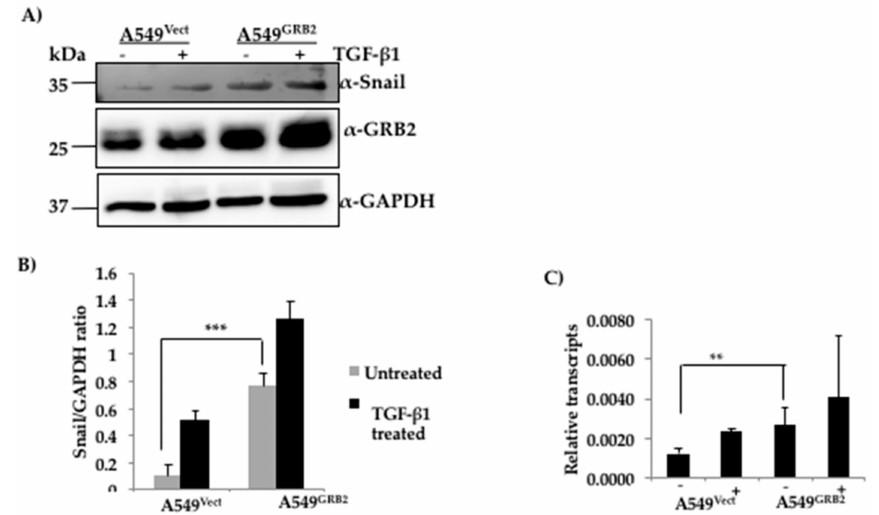
Figure 5. Expression of SNAIL is increased in GRB2 overexpressing A549 cells. ( A ) Protein extracts from A549 Vect and A549 GRB2 cells, before and after TGF- β 1 treatment, were subjected to Western blot using antibodies against Snail and GRB2. GAPDH was used as the loading control; ( B ) Densitometric analysis of SNAIL expression level was carried out using Image J software. (*** p < 0.001); ( C ) RNA was extracted from the samples using Trizol reagent, converted to cDNA and used to carryout qPCR using Snail primers. MRPL27 was used as the control. Relative abundance of GRB2 normalised against MRPL27 for two independent experiments was plotted (** p < 0.01, *** p <